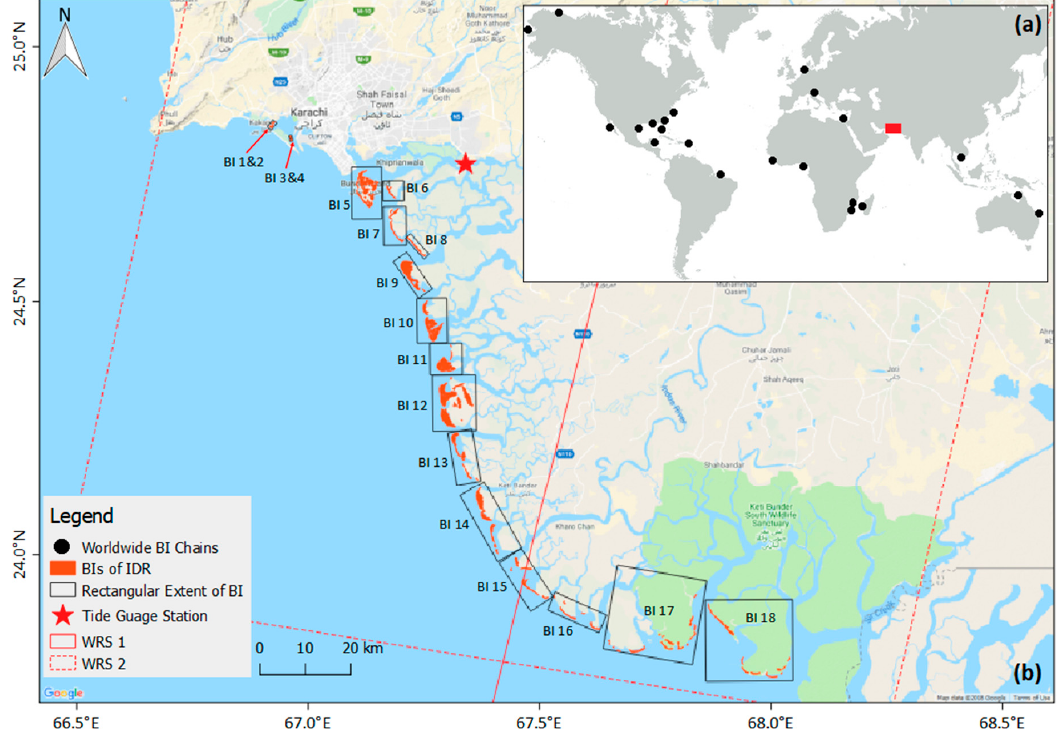
Figure 1. ( a ) Location of study area (filled red rectangle) and worldwide Barrier Island (BI) chains (black dots) derived from [23] and ( b ) barrier islands located within Indus Delta Region (IDR).